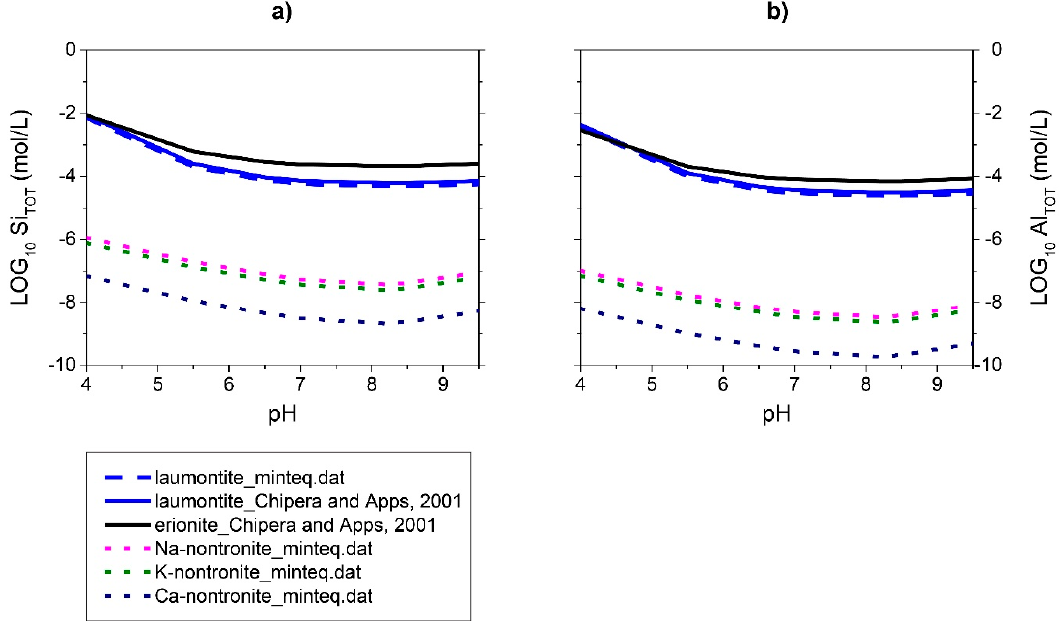
Figure 11. Solubility of erionite and nontronite calculated as function of pH: ( a ) total Si concentration at equilibrium and ( b ) total Al concentration at equilibrium. Results obtained for laumontite are also reported as a reference.